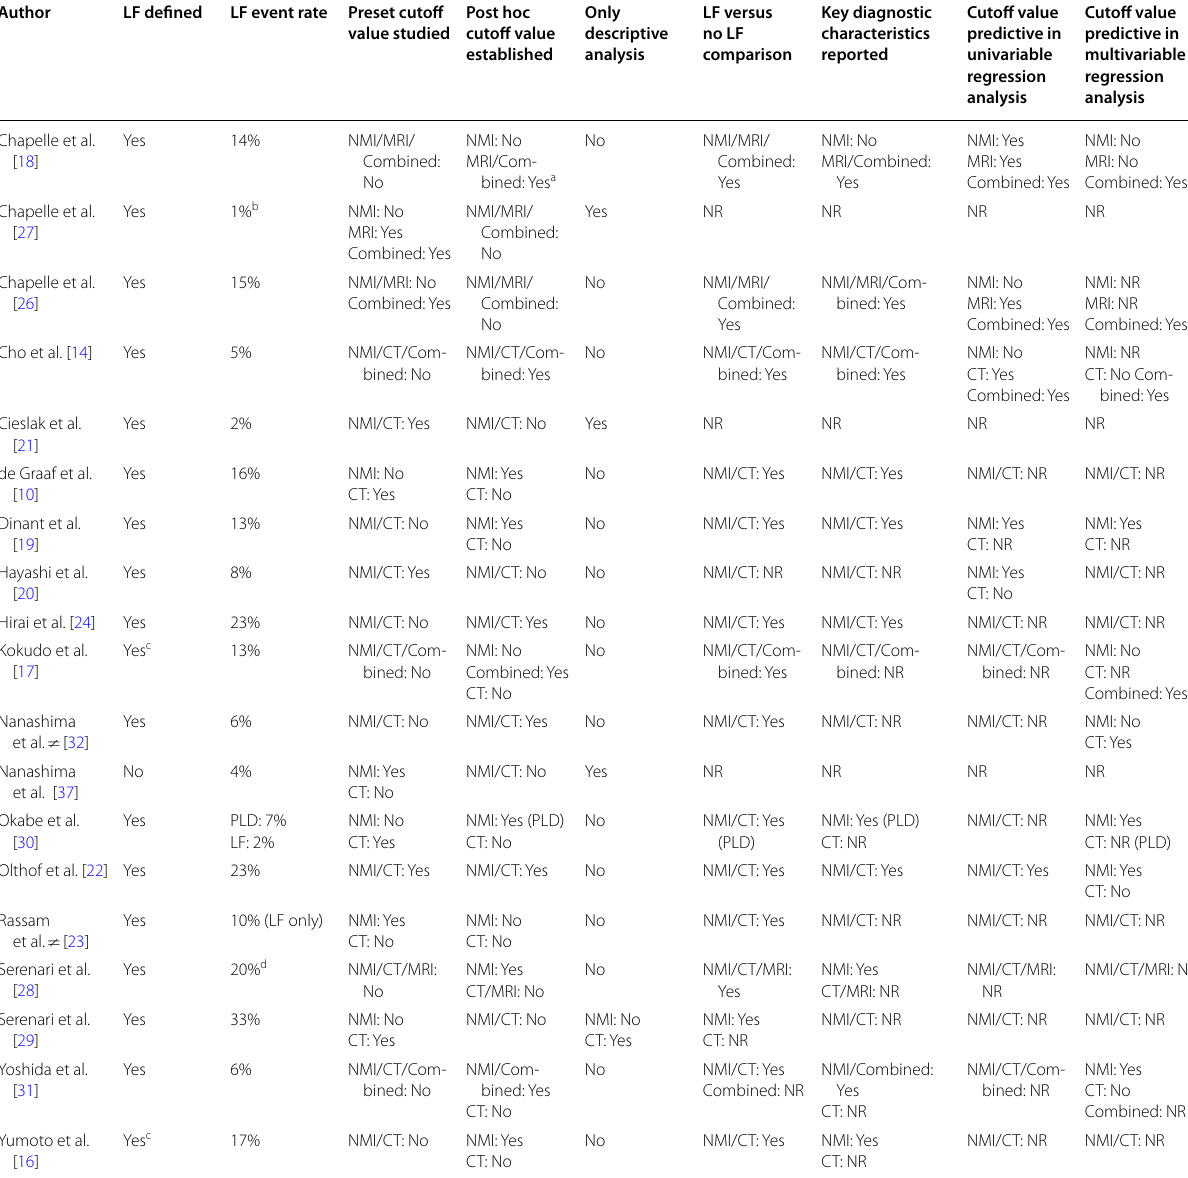
Table 3 Overview of trials reporting on preoperative nuclear medicine imaging and computed tomography or magnetic resonance imaging for the prediction of postoperative liver